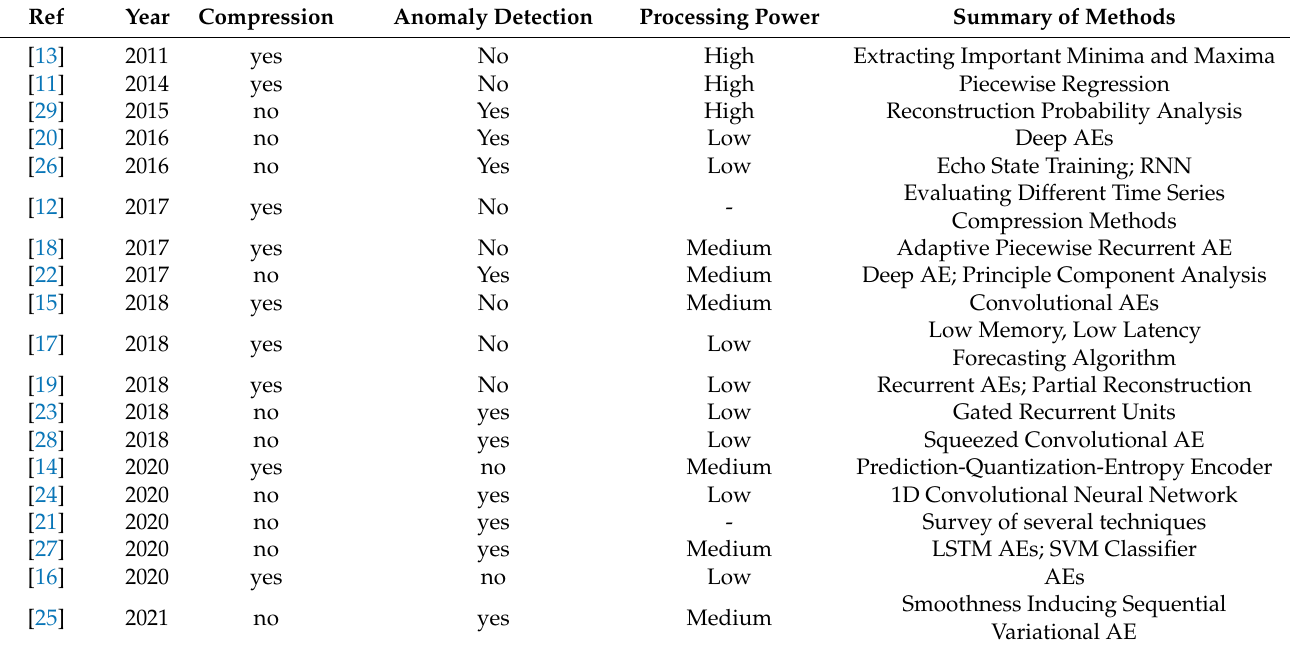
Table 1. State-of-the-art summary (sorted by